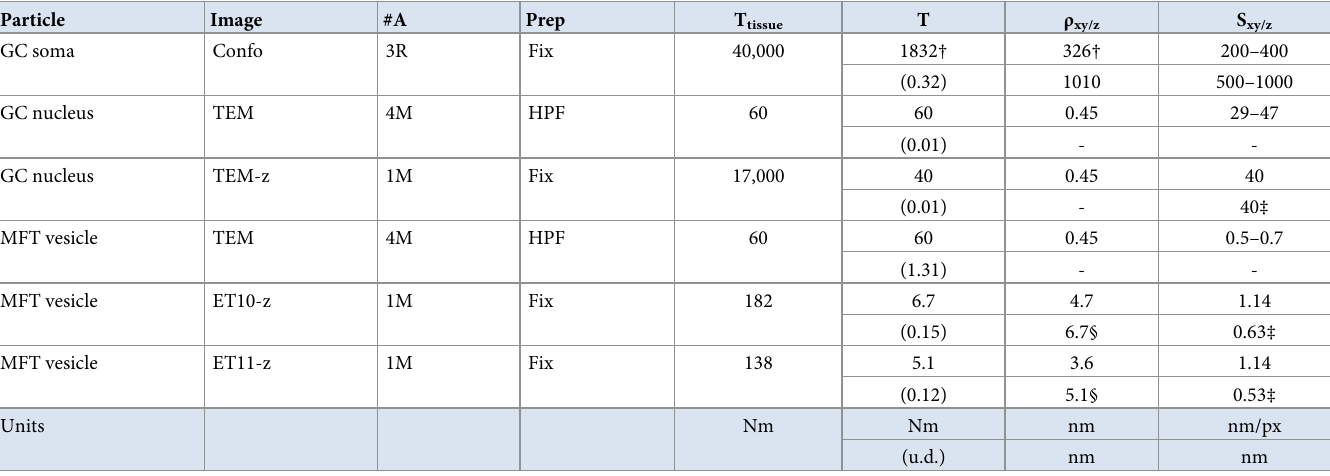
Table 1. Experimental conditions for confocal, TEM and ET imaging. Particle Image #A